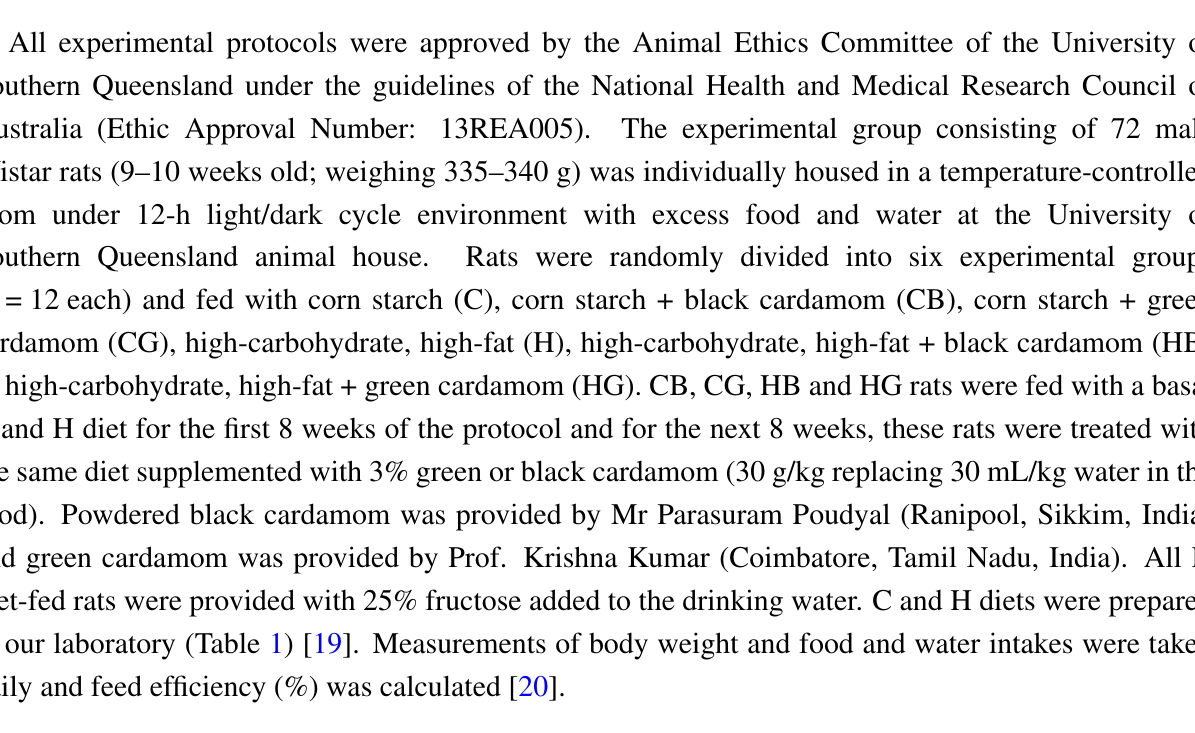
Table 1. Composition of corn starch (C) and high-carbohydrate, high-fat (H) diets. Ingredient,